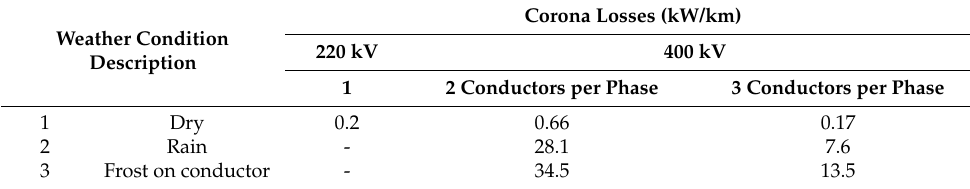
Table 1. Corona losses due the different weather conditions (adopted from [5], 2018, HRO CIGRE). Weather Condition Description